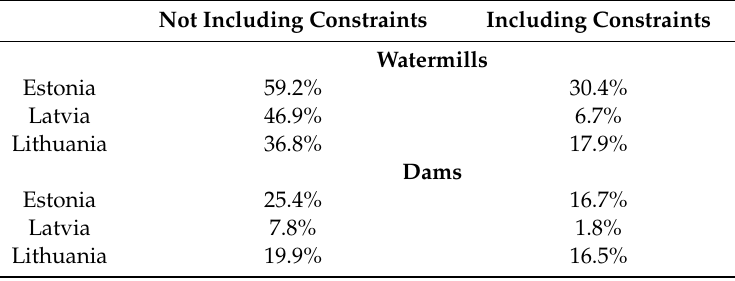
Table 5. Share of the historic sites in the remaining small hydropower potential in the Baltic